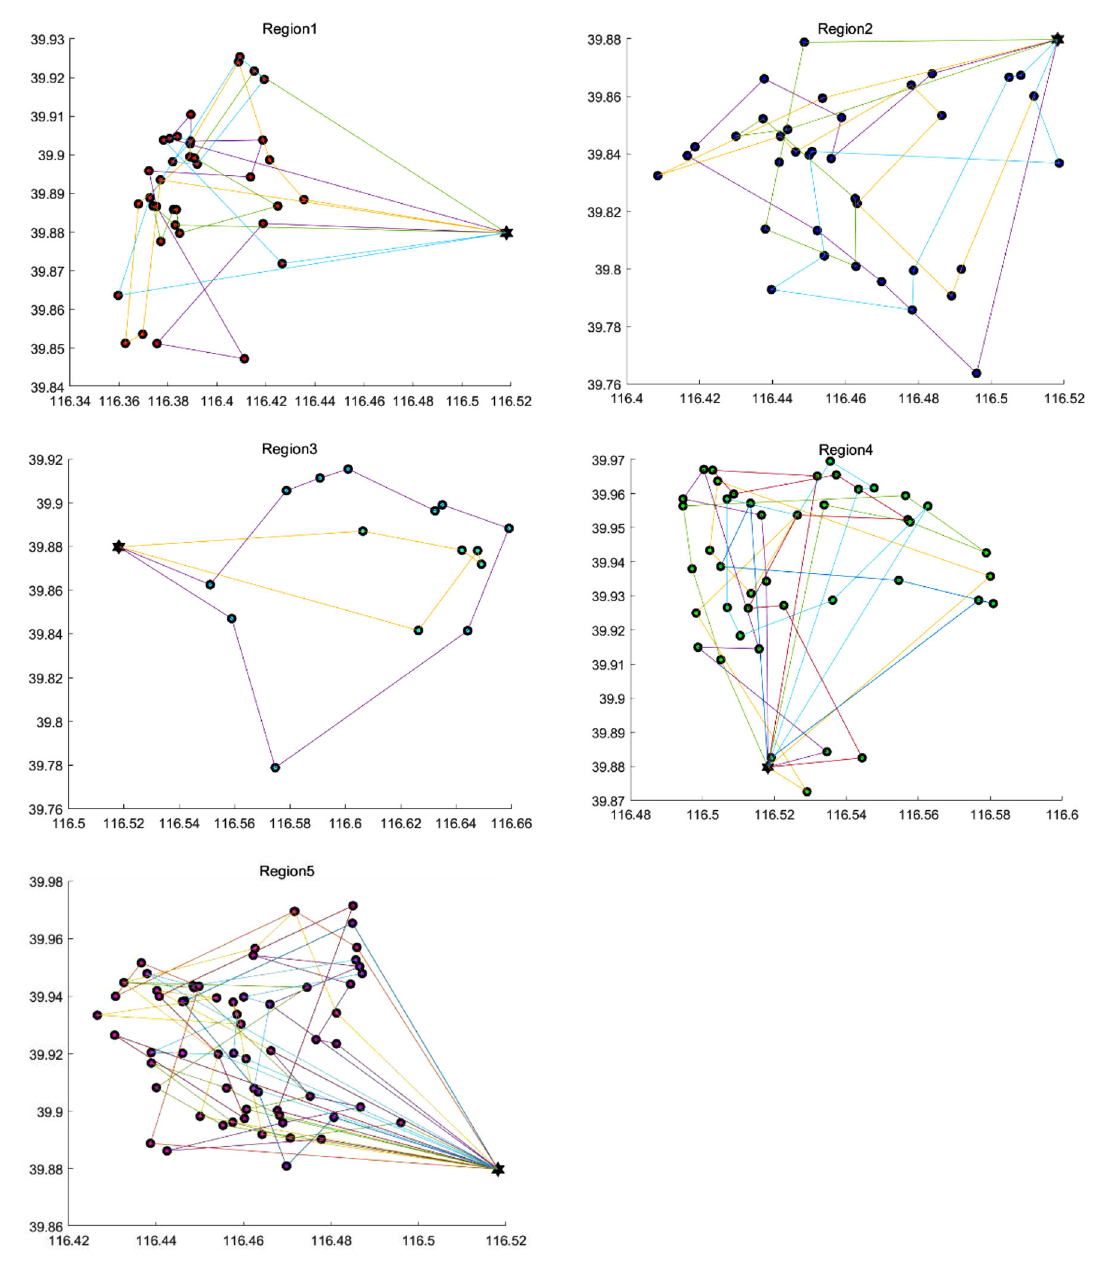
Fig. 8 Distribution path for each region Table 5 Total time, cost, mileage and load in each region